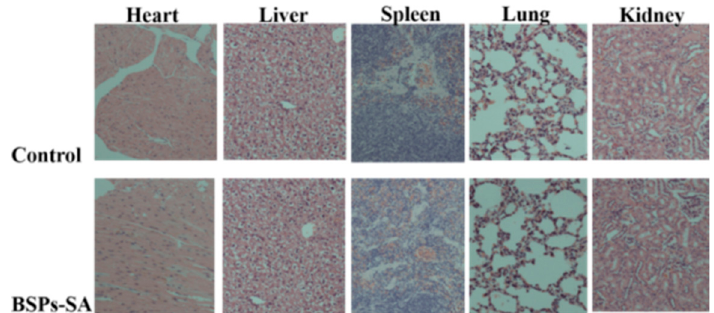
Figure 9. Histological images of heart, liver, lung, spleen, and kidney. The histological examination images are offered with a magnitude 200×.